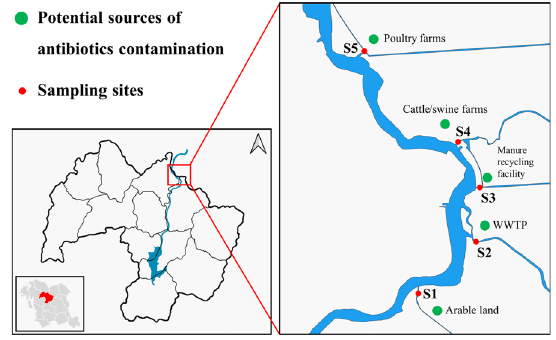
Fig. 2 Map of Muhan river with sampling sites and potential sources of antibiotics